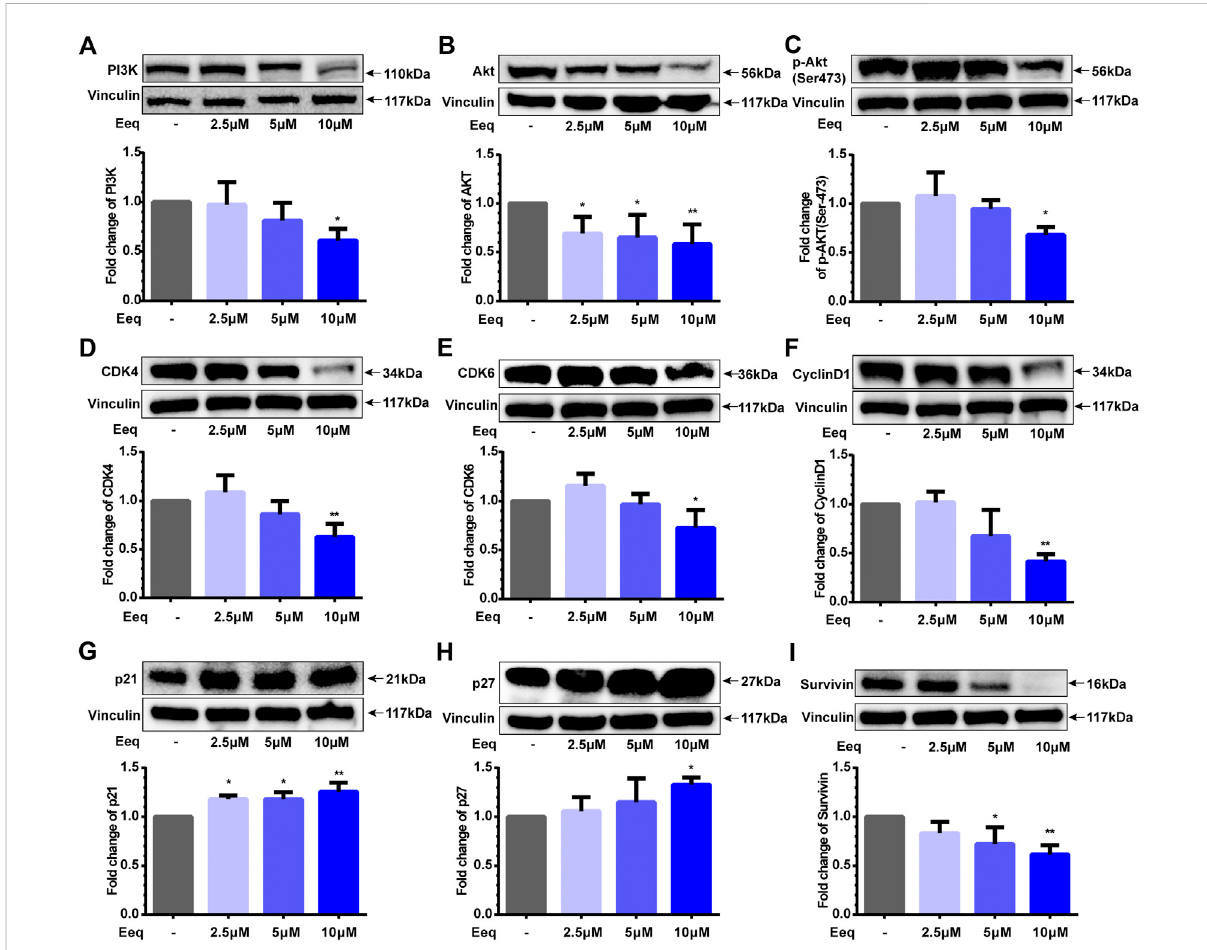
FIGURE 2 5 ′ -Epiequisetin(Eeq)regulatedtheexpressionofproliferation-relatedproteins. (A) PI3K, (B) Akt, (C) phosphorylatedAkt, (D) CDK4, (E) CDK6, (F) cyclin D1, (G) p21, (H) p27, and (I) survivin. * p < 0.5, ** p < 0.01 vs .